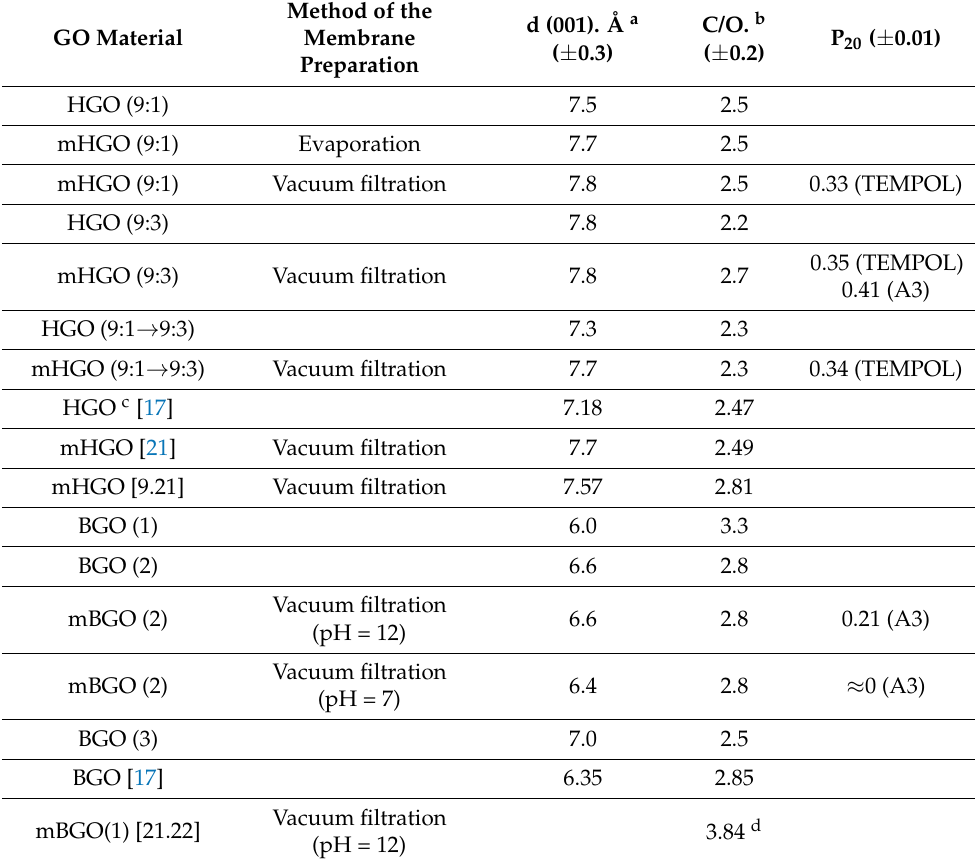
Table 1. Parameters of the dry HGO and BGO powders and